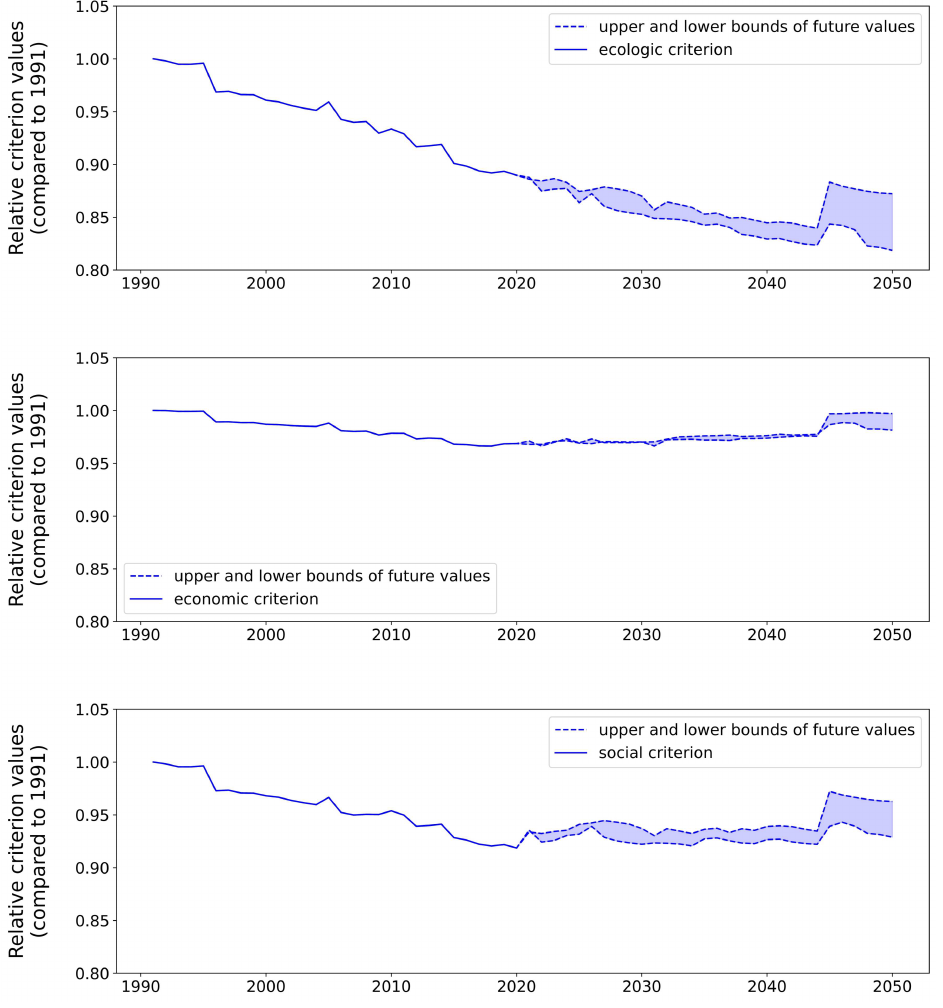
Figure 16. Retrospective (1991–2021) and forecast (2022–2050) dynamics of ESES at ε = 0.1 and n 1 =